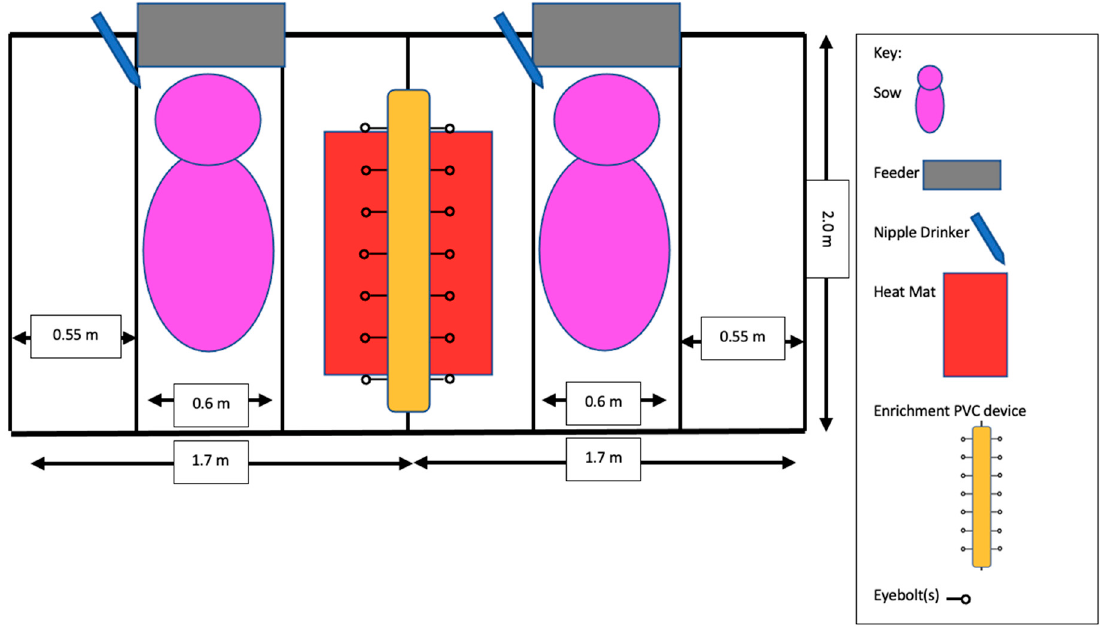
Figure 1. Diagram of two farrowing stalls with one PVC (polyvinyl chloride) device between them. Enrichment ropes were hung off the eyebolts connected to each PVC device.